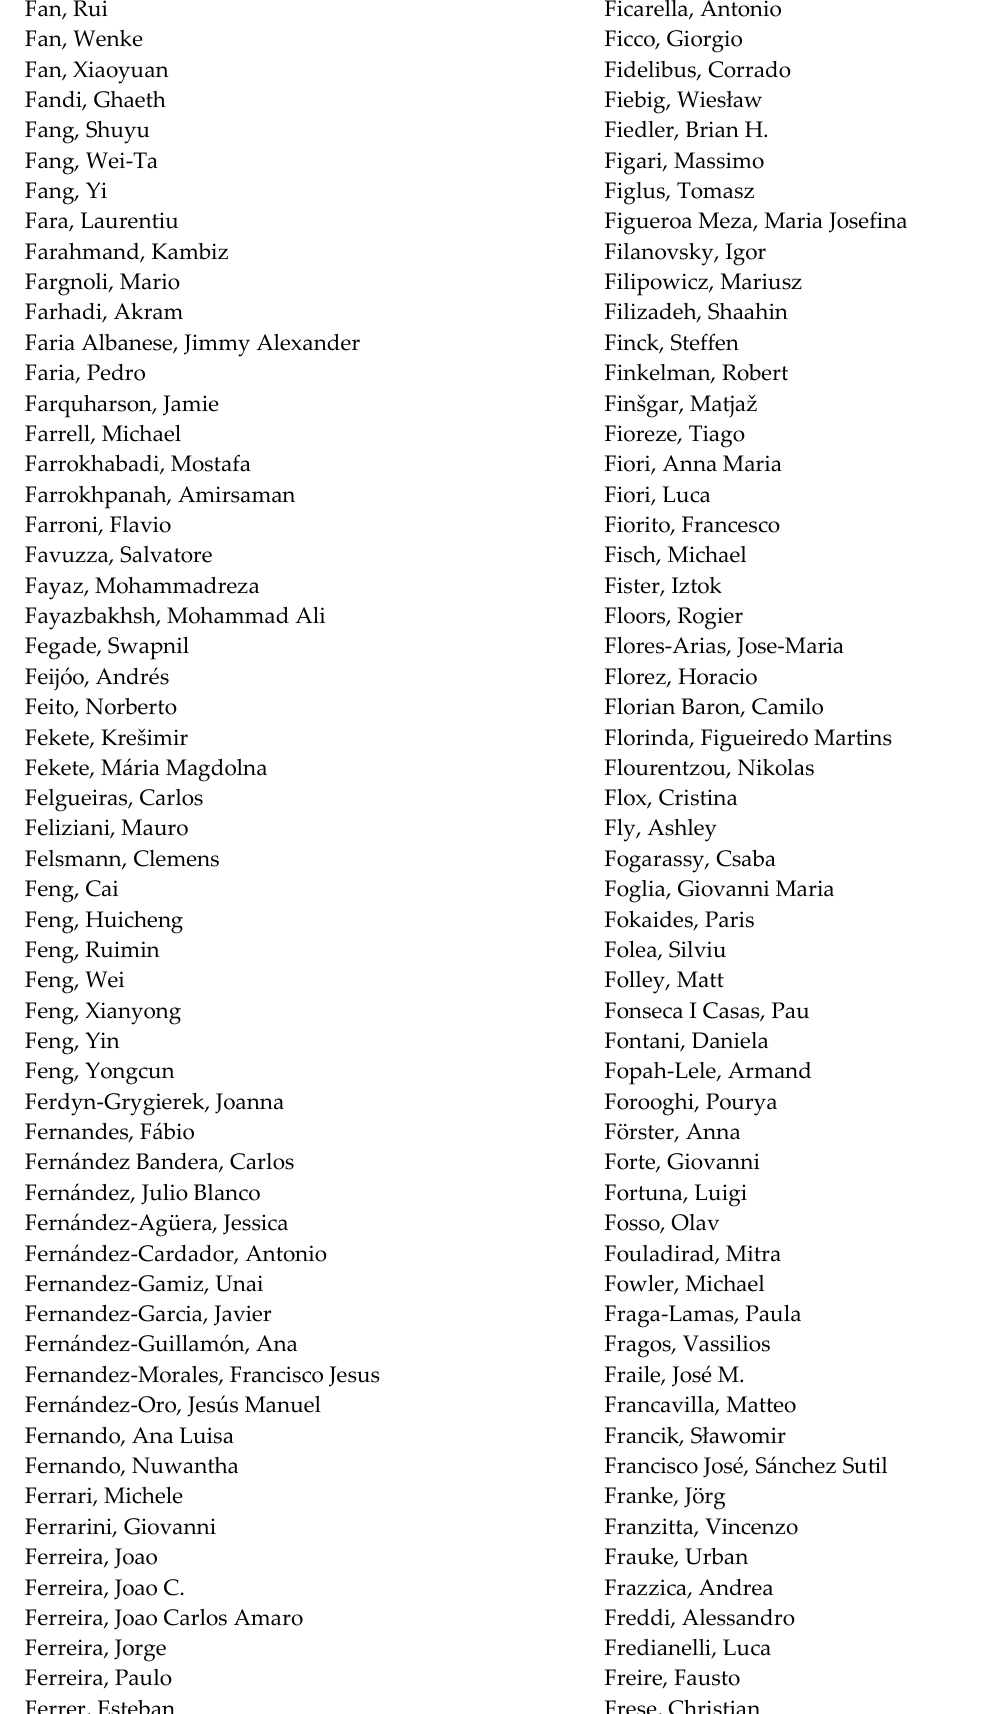
Figari, Massimo Figlus, Tomasz Figueroa Meza, Maria